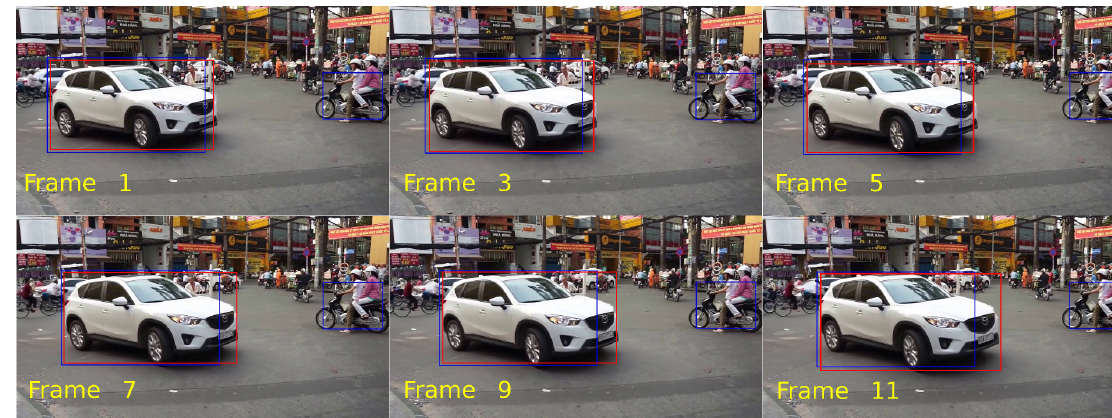
Figure 17. Example of tracking using KCF compared with YOLOv2 detection. Sequence of 11 frames. YOLOv2 in red, KCF in blue. At the front of the car, it can be seen that the longer the tracking period, the less accurate the result, with the KCF bounding box increasingly differing from the YOLOv2 bounding